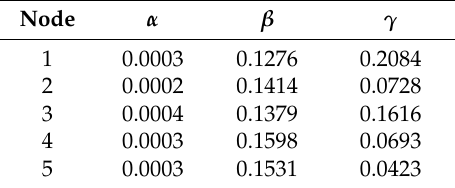
Table 4. The parameters of the five-MESCs system using the battery-capacity-based allocation